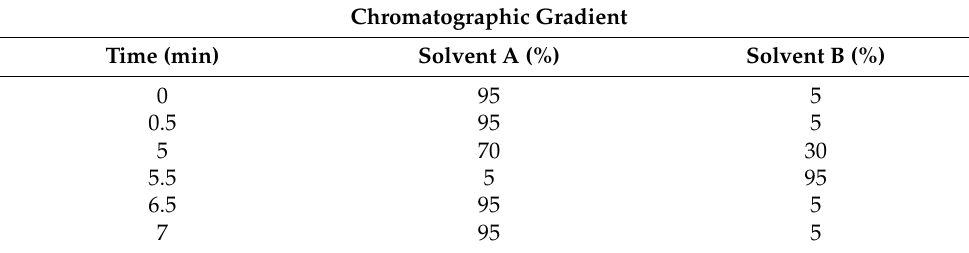
Table 1. Gradient elution of mobile